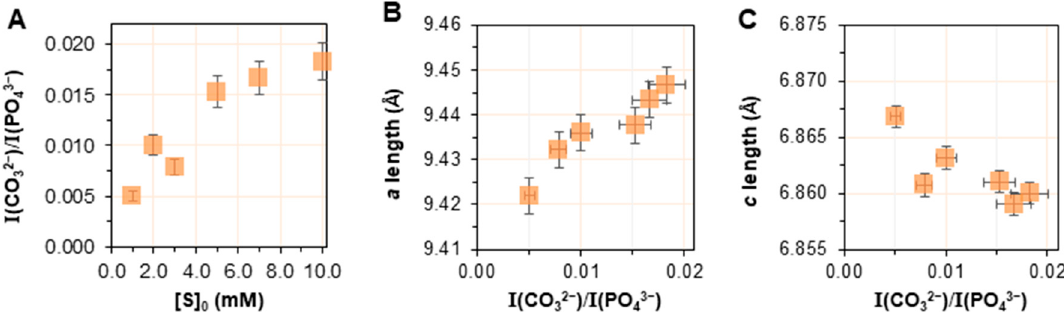
Figure 7. ( A ) Intensity of v 2 (CO 32 − ) band divided by the intensity of v 1,3 (PO 43 − ), I(CO 32 − )/I(PO 43 − ), plot- ted as a function of [S] 0 ; ( B , C ) a and c lattice parameters plotted as a function of the I(CO 32 − )/I(PO 43 − ) ratio.